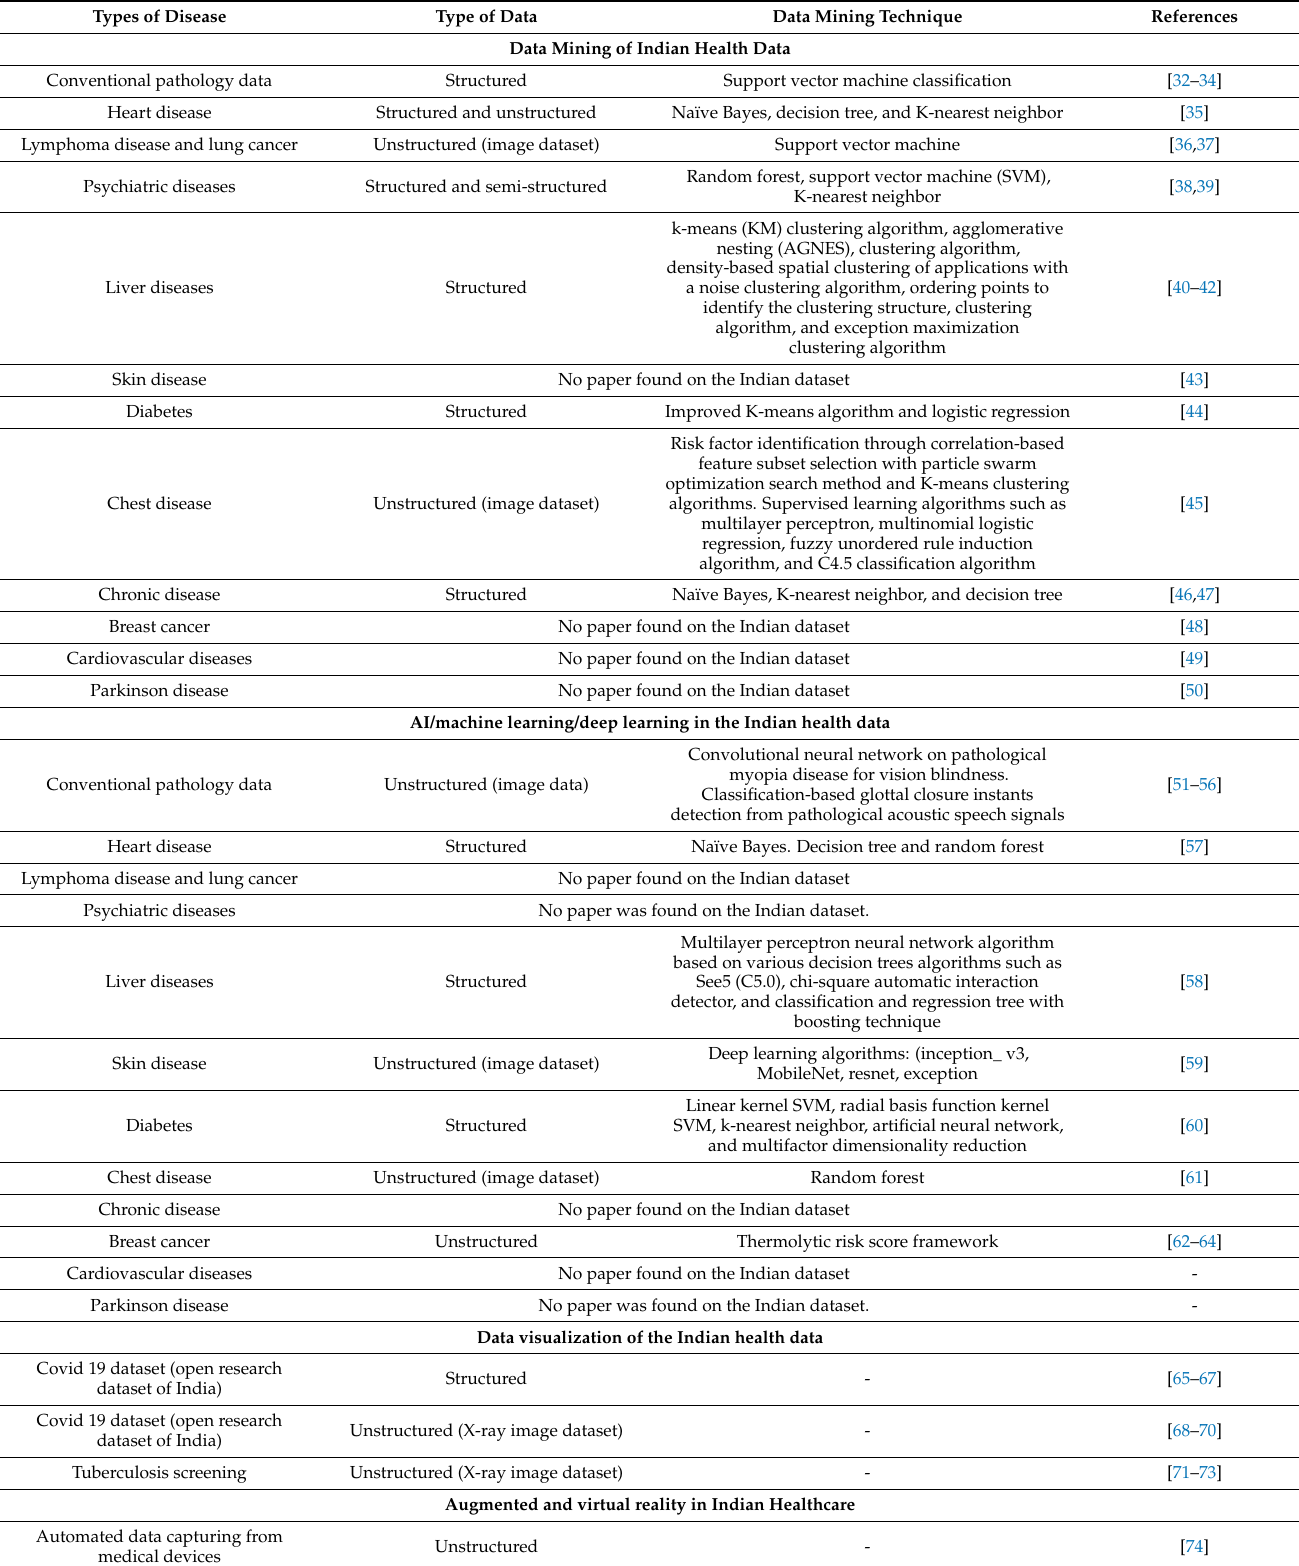
Table 7. Existing research in the Indian healthcare industry.